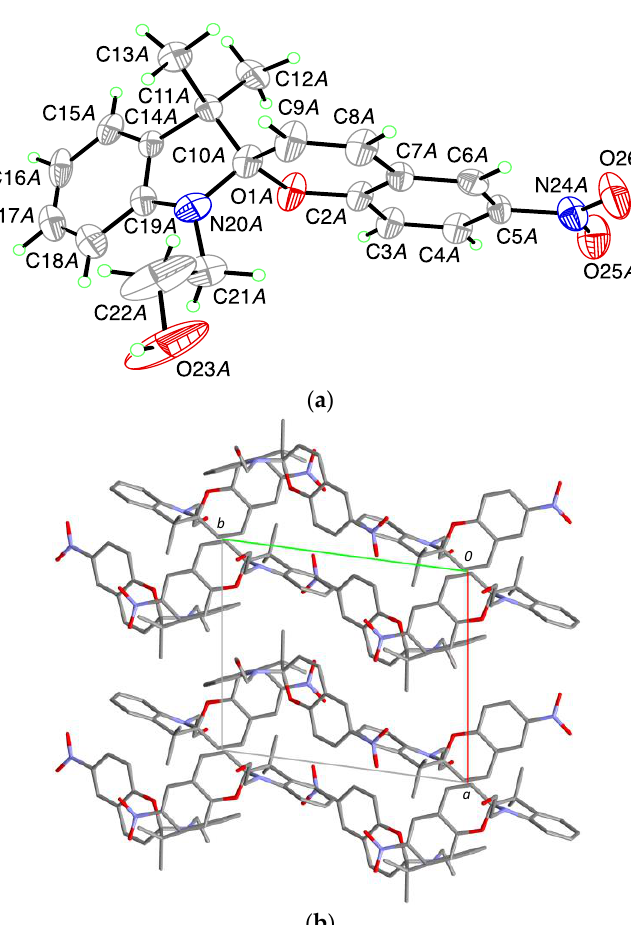
Figure 3. ( a ) A perspective view of (III), showing the atom-numbering scheme. Displacement ellipsoids are drawn at the 20% probability level. The figure is limited to one of the two molecules in the asymmetric unit. ( b ) A partial packing diagram for (III). Only the major occupied site of the disordered side chain is shown in ( a , b ).